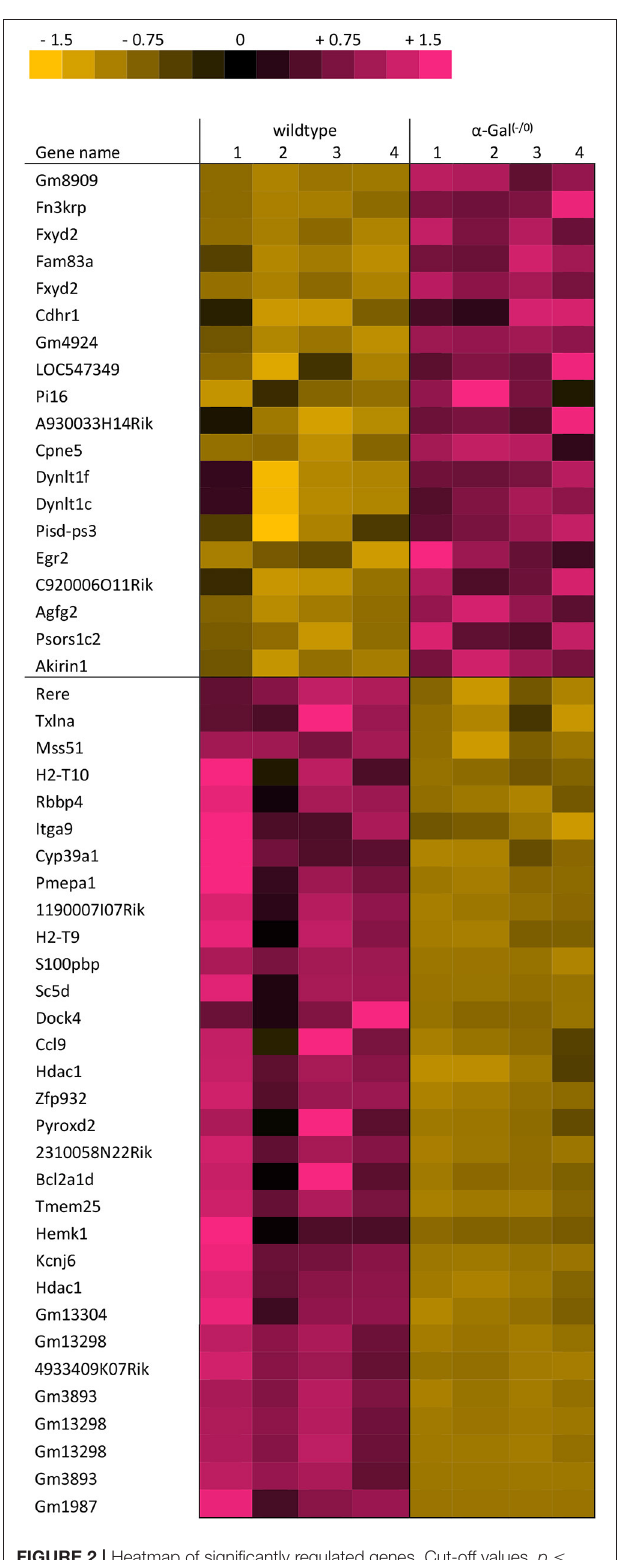
FIGURE 2 | Heatmap of significantly regulated genes. Cut-off values, p ≤ 0.01, fold change ≥